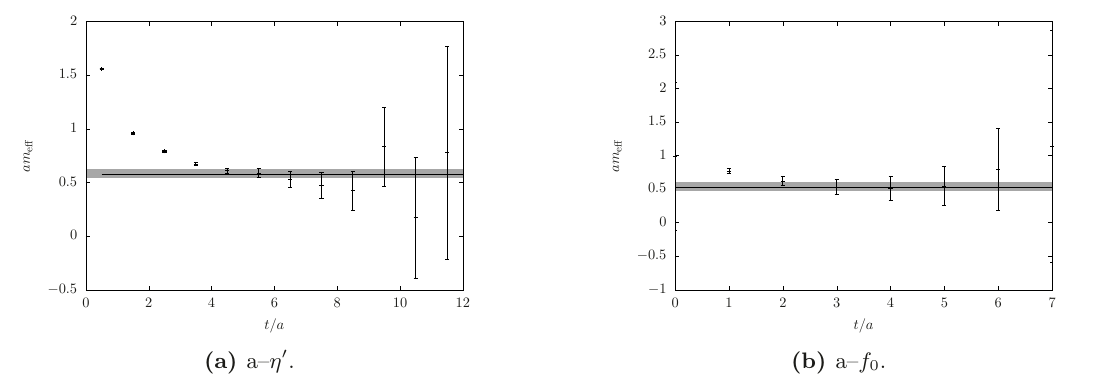
Figure 5. Mass plateau for the mesons a– η ′ and a– f 0 for β = 5 . 5, κ = 0 . 1673, on a 16 3 × 32 lattice. The final value indicated by the gray line is obtained from a fit of the correlation function.